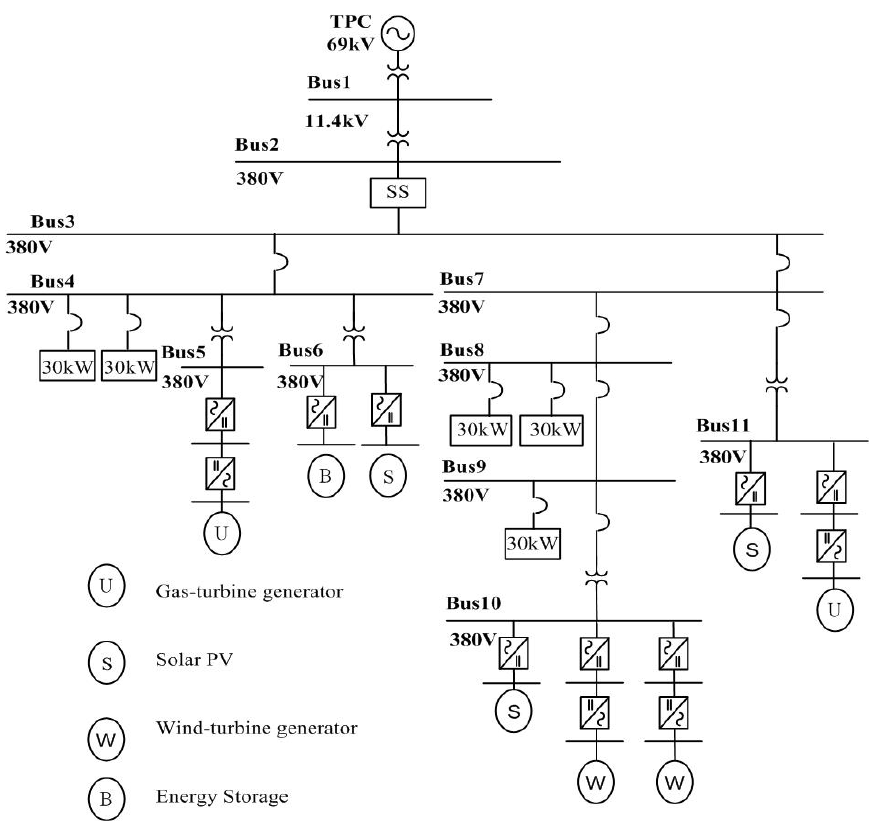
Figure 1. One-line diagram of studied microgrid with converters. PV: